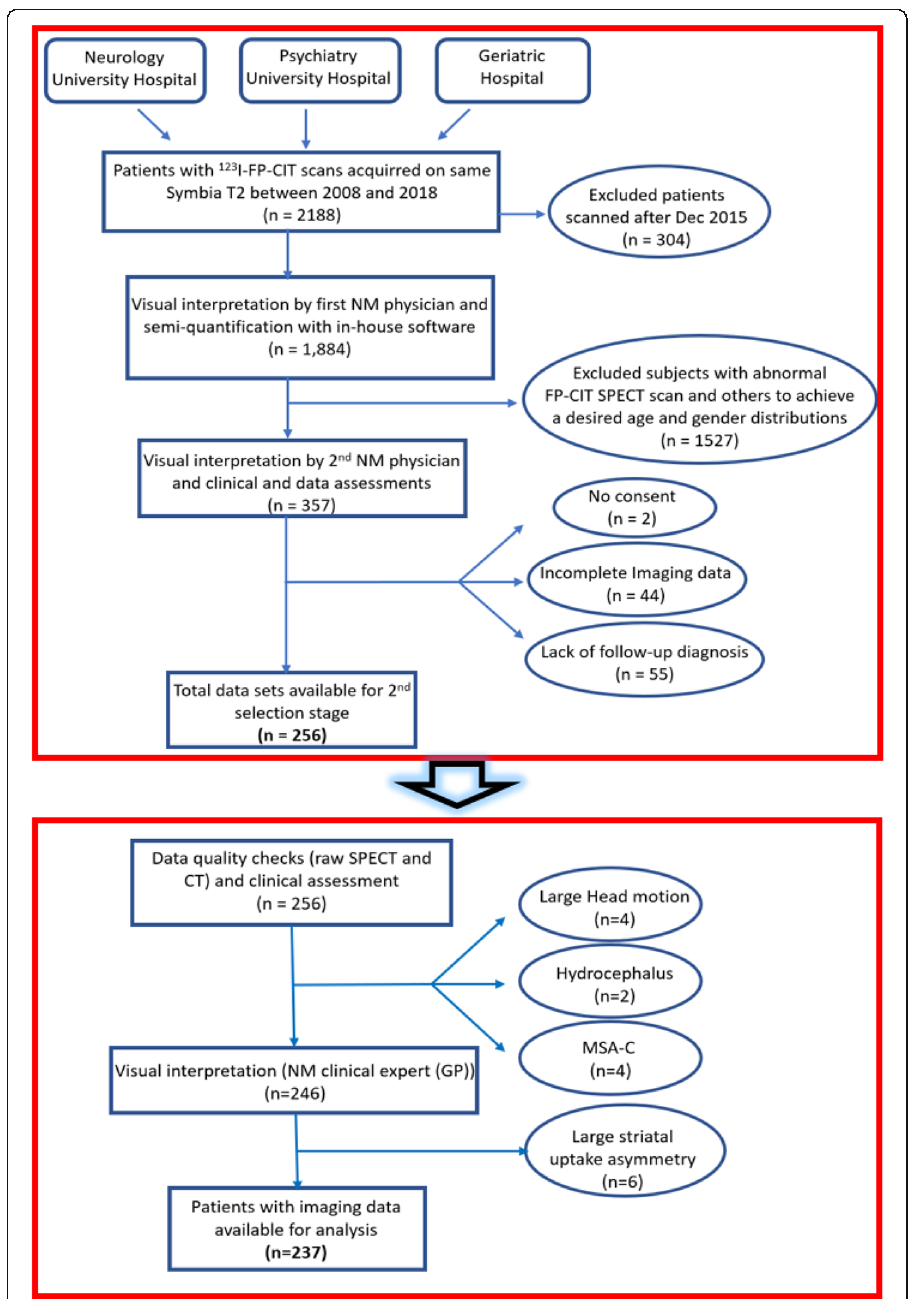
Fig. 1 Diagram showing the two-stage selection procedure for patients ’ selection and inclusion in the present study. The top panel corresponds to stage 1 (clinical site, Lyon, France), and the bottom panel corresponds to the second selection stage (Siemens Medical Solutions USA, Inc., Molecular Imaging, Knoxville, TN). MSA-C cerebellar multi-system